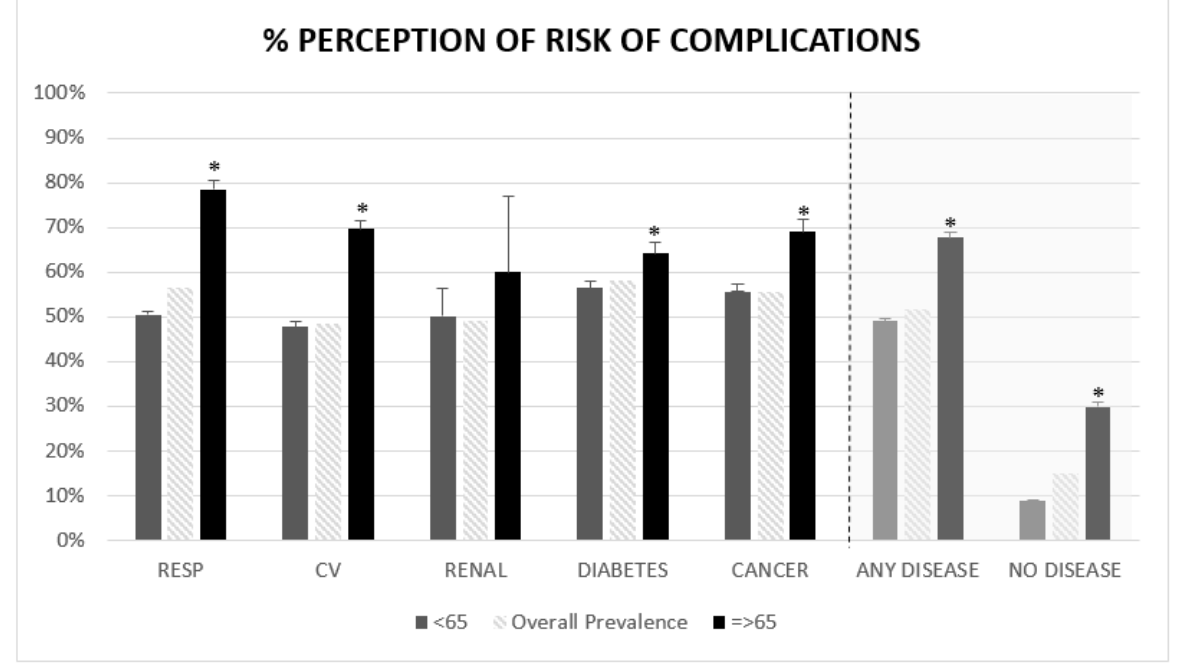
Figure 1. Age-specific and standardized prevalence of self-perceived risk for developing severe disease outcomes following COVID-19 infection (n=171,087). "a" indicates a significant difference ( P <.001) in terms of risk perception between those aged <65 years and ≥ 65 years. RESP: respiratory, CV: